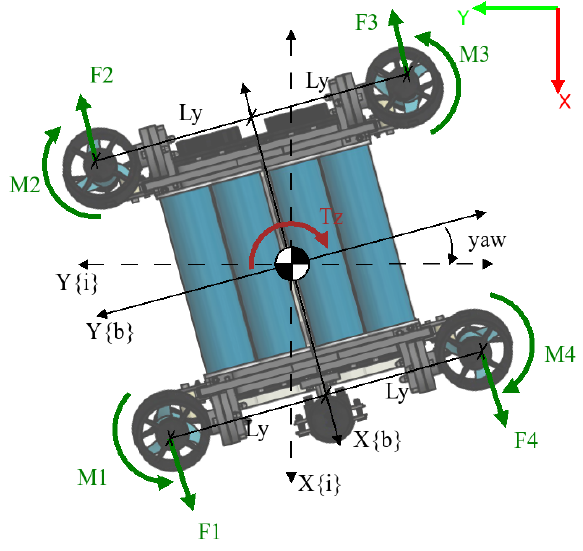
Figure 9. The applied forces visible on the X–Y plane of the body-fixed frame.